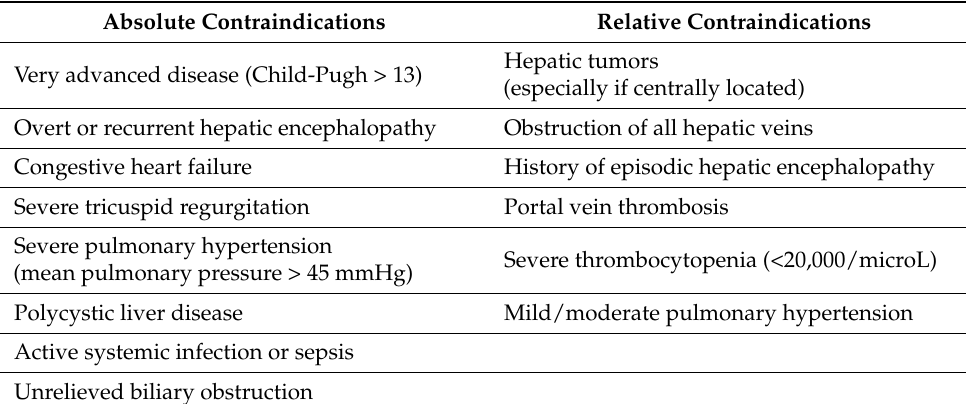
Table 2. Contraindications to TIPS placement. Absolute Contraindications Relative Contraindications Hepatic tumors Very advanced disease (Child-Pugh > 13) (especially if centrally located) Overt or recurrent hepatic encephalopathy Obstruction of all hepatic veins Congestive heart failure History of episodic hepatic encephalopathy Severe tricuspid regurgitation Portal vein thrombosis Severe pulmonary hypertension Severe thrombocytopenia (<20,000/microL) (mean pulmonary pressure > 45 mmHg) Polycystic liver disease Mild/moderate pulmonary hypertension Active systemic infection or sepsis Unrelieved biliary